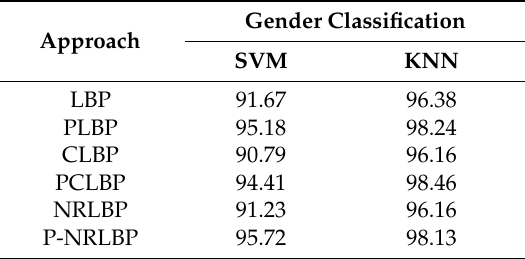
Table 5. Classification Rates for Gender for YVG (PICS